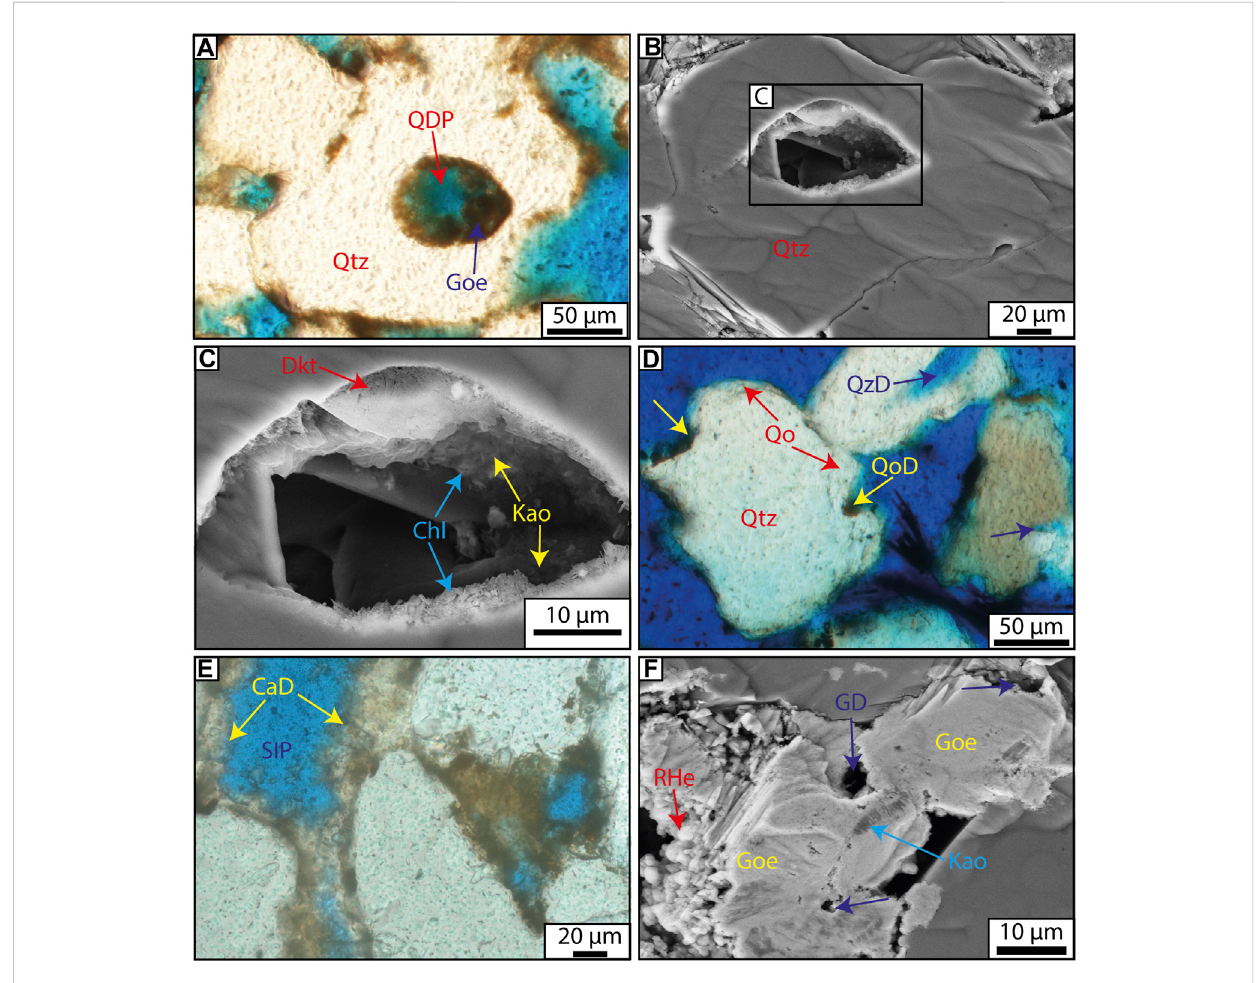
FIGURE 14 Photomicrographs showing mineral dissolutions and replacements. (A) Quartz (Qtz) dissolution pore (QDP) being fi lled by goethite (Goe). (B) Dissolution of quartz grain around the center of the grain. (C) Inset of (B) showing secondary-dissolution pore in quartz being fi lled by dickite (Dkt), chlorite (Chl) and kaolinite (Kao). (D) Quartz dissolution (QzD) around grain edges and dissolution (QoD) of quartz overgrowths (Qo), creating embayments on the grain. (E) Early calcite undergoing pervasive dissolution (CaD) and creating secondary intergranular porosity (SIP). (F) Goethite (Goe) undergoing dissolution (GD) and replacement by rounded hematite (RHe). Note how goethite engulfs kaolinite